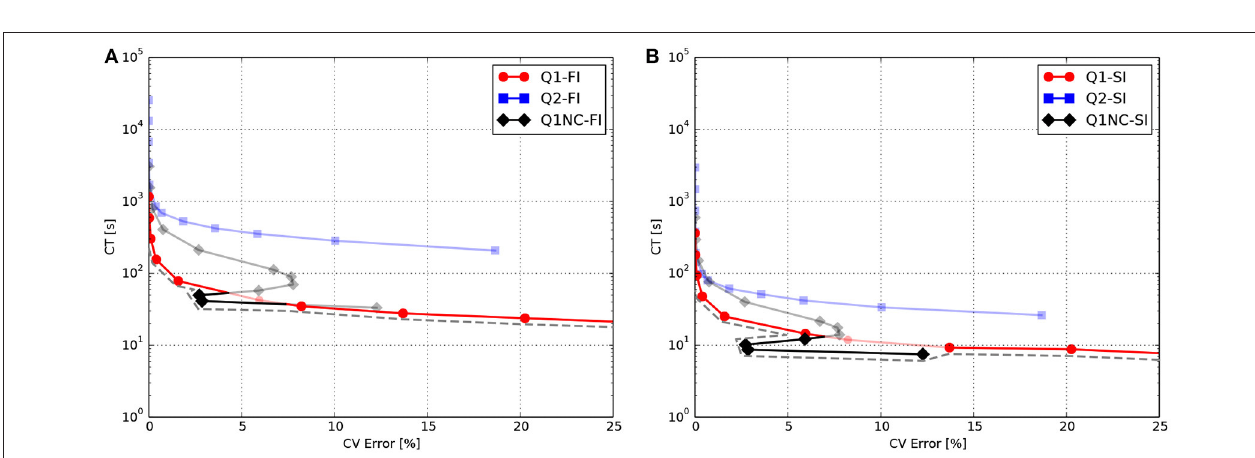
FIGURE 2 | Accuracy-efficiency analysis: Computation time vs. conduction-velocity error for the different spatial discretization schemes using (A) fully-implicit time integration, and (B) semi-implicit time integration. Dashed gray line displays the Pareto frontier, which encompasses optimal cases. Suboptimal combinations are shown in transparent